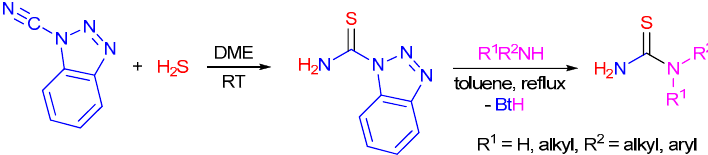
Figure 2. Bis-imidazole thiourea used in the synthesis of other derivatives [92].